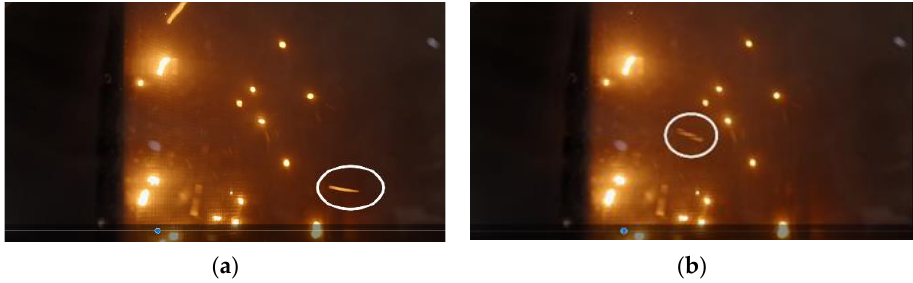
Figure 8. A firebrand passes through the mesh without any contact, ( a ) approaching firebrand, ( b )